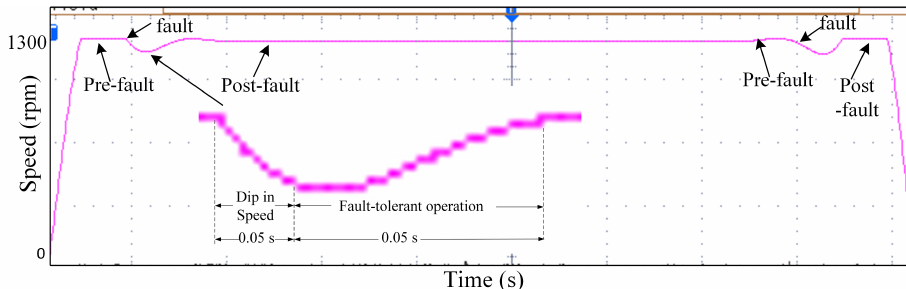
Figure 15. Speed response under fault-tolerant operation.